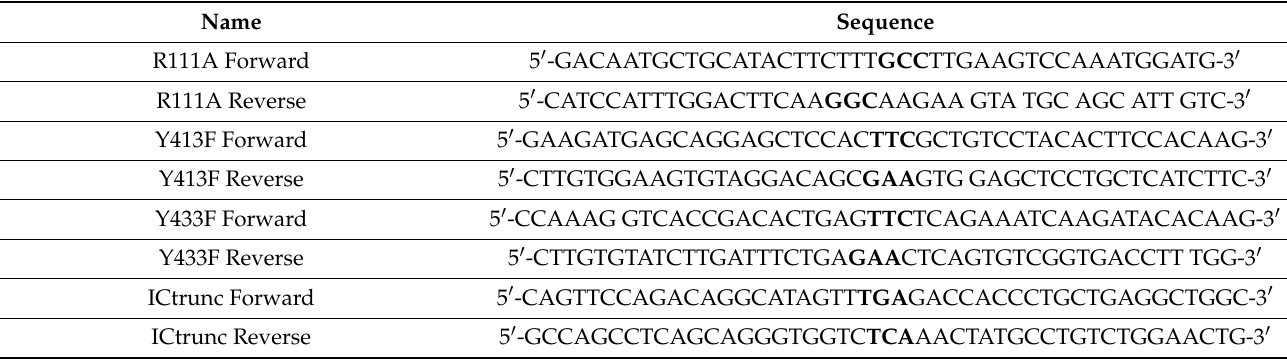
Table 1. Primers used for mutagenesis in this study.